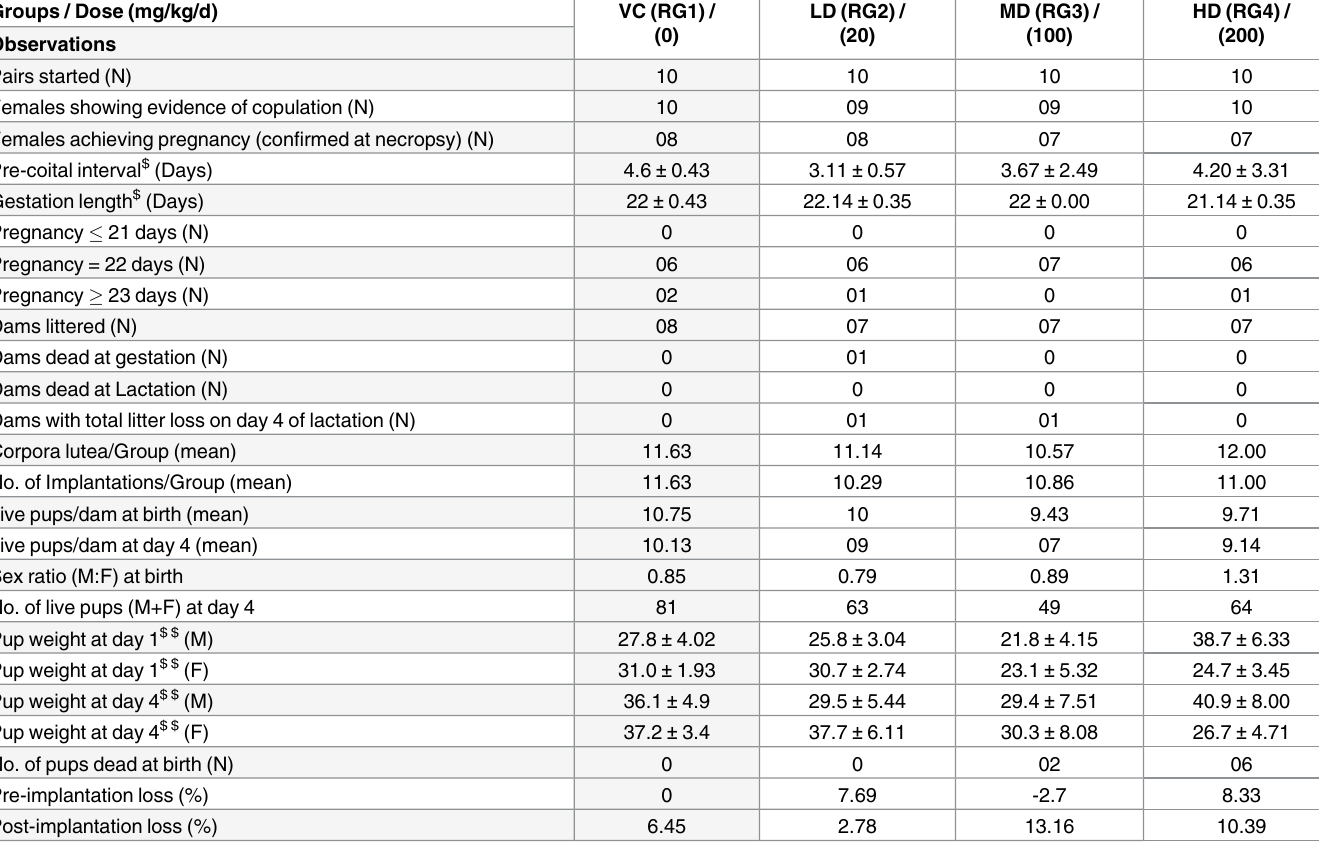
Table 10. Summaryof effectsof 3’-HPT administration on reproduction/development in Wistar rats. Groups / Dose